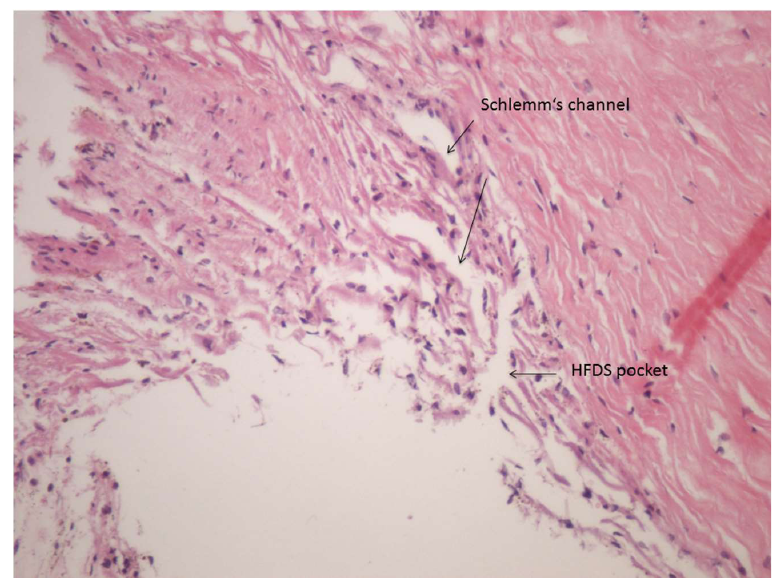
Figure 3. Histological analysis of a high-frequency deep sclerotomy (HFDS) cut (HE staining, human eye).